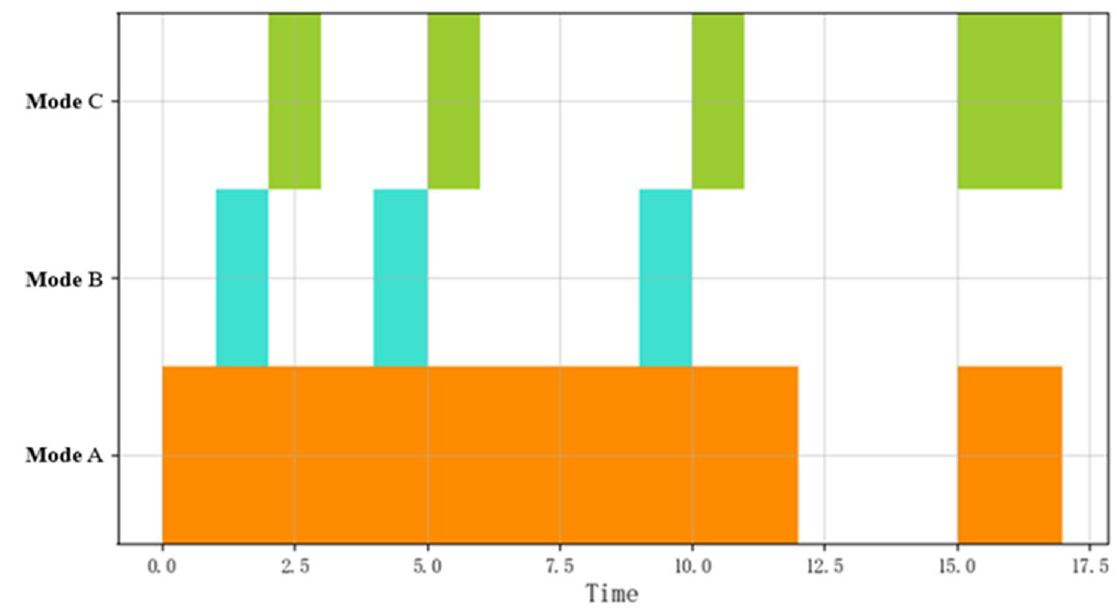
Figure 7. Visualization of the event flow composite composition.